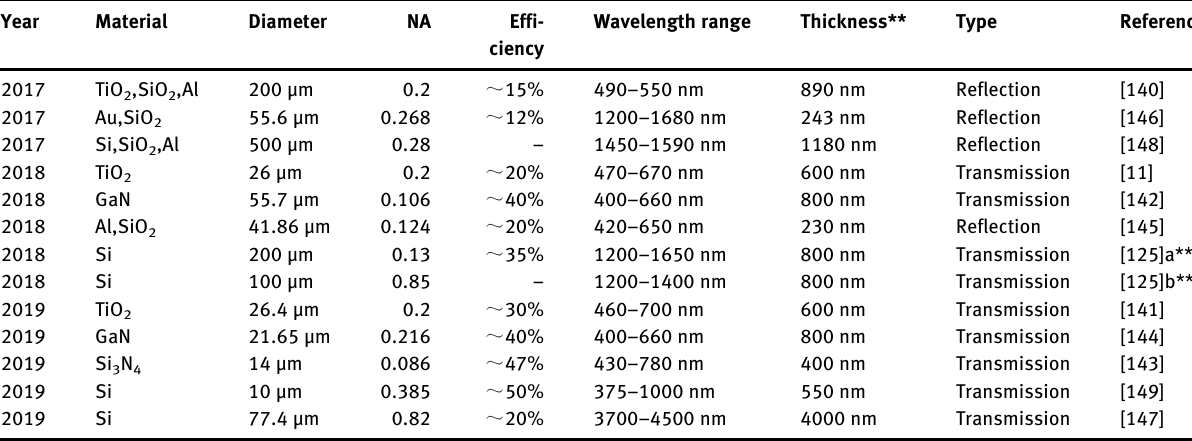
Table  : Summary of performance of broadband metalenses.